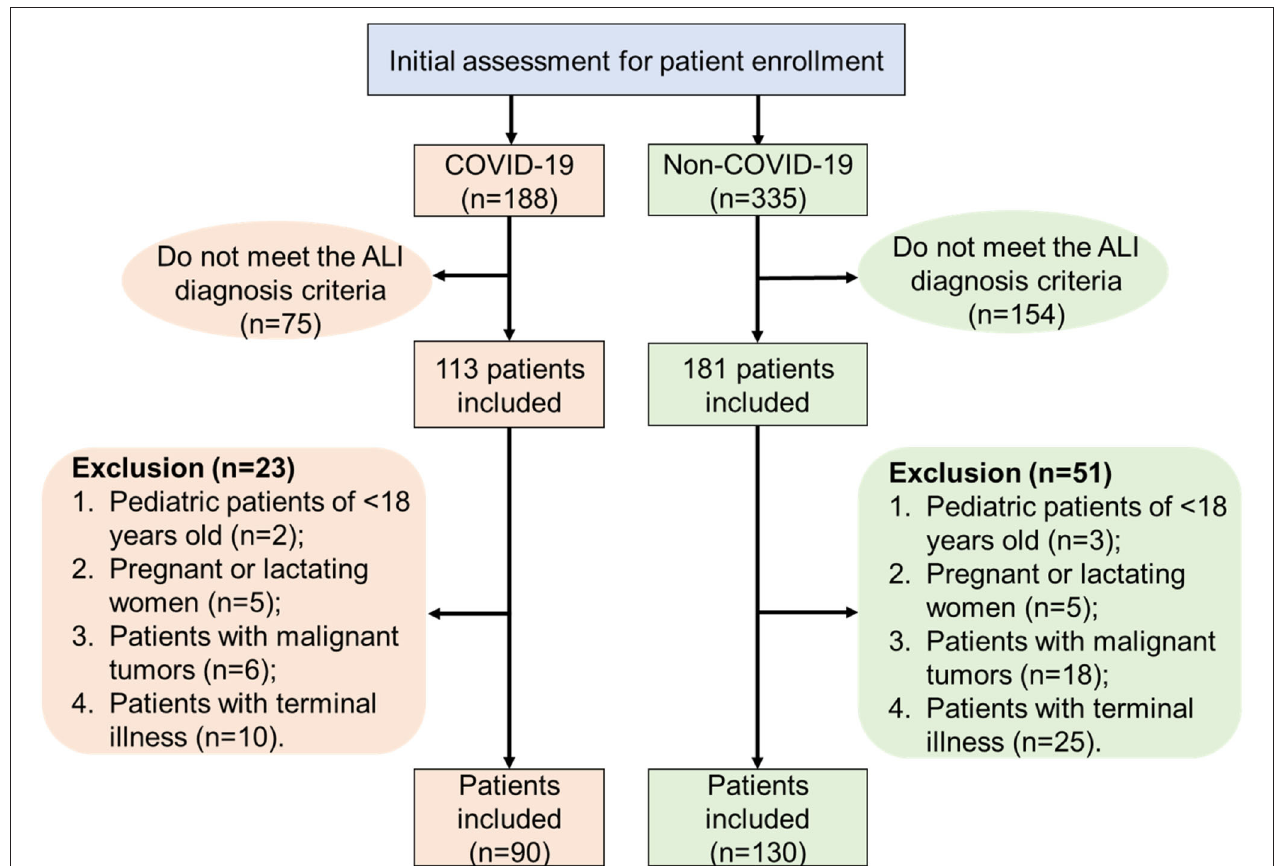
FIGURE 1 | A flowchart that illustrates patient inclusion and exclusion criteria in the patient selection procedure.